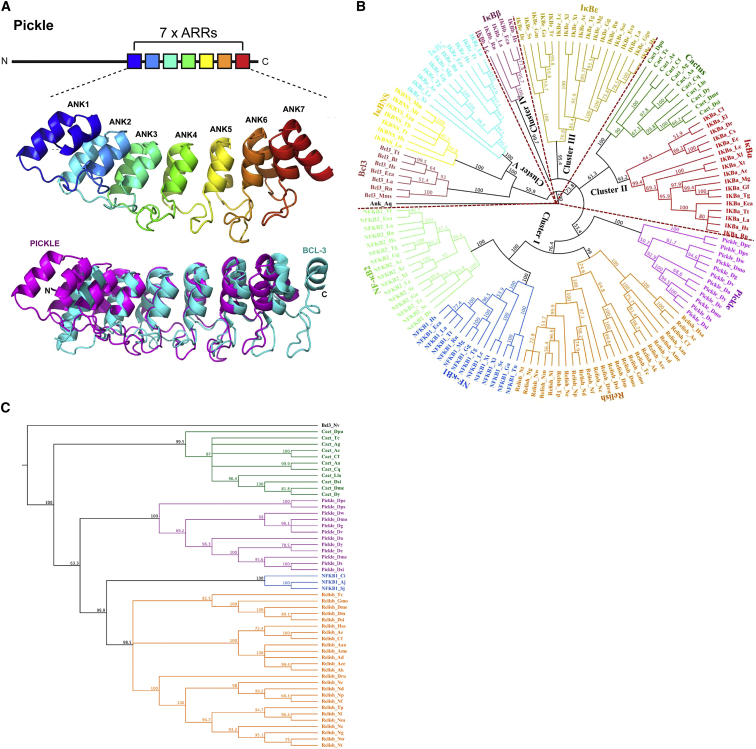
Phylogenetic Relationship of Pickle with Other IκB Family Members(A) Schematic representation of Pickle (top) and its predicted 3D structure (middle). The predicted structure of the seven ARRs of Pickle (magenta) was superimposed onto the structure of Bcl-3 (PDB: 1K1A; cyan) (bottom).(B) Phylogenetic analysis of IκB proteins. The sponge Amphimedon queenslandica was considered as an out-group. Bootstrap values > 50% have been provided. Members: IκBα (red), IκBβ (wine), IκBε (tan), Bcl-3 (brown), IκBNS (yellow), IκBζ (cyan), Cactus (dark green), Relish (orange), NF-κB1 (blue), NF-κB2 (light green), and Pickle (magenta).(C) Phylogenetic relationship of Pickle with IκB family members present in invertebrates only using neighbor-joining method. Bcl-3 from Nematostella vectensis was considered as an outgroup (shown in black). Bootstrap scores > 60% have been provided. Members: Cactus (dark green), Relish (orange), NF-κB1 (blue), and Pickle (magenta).See Table S1 for details. See also Figure S2.